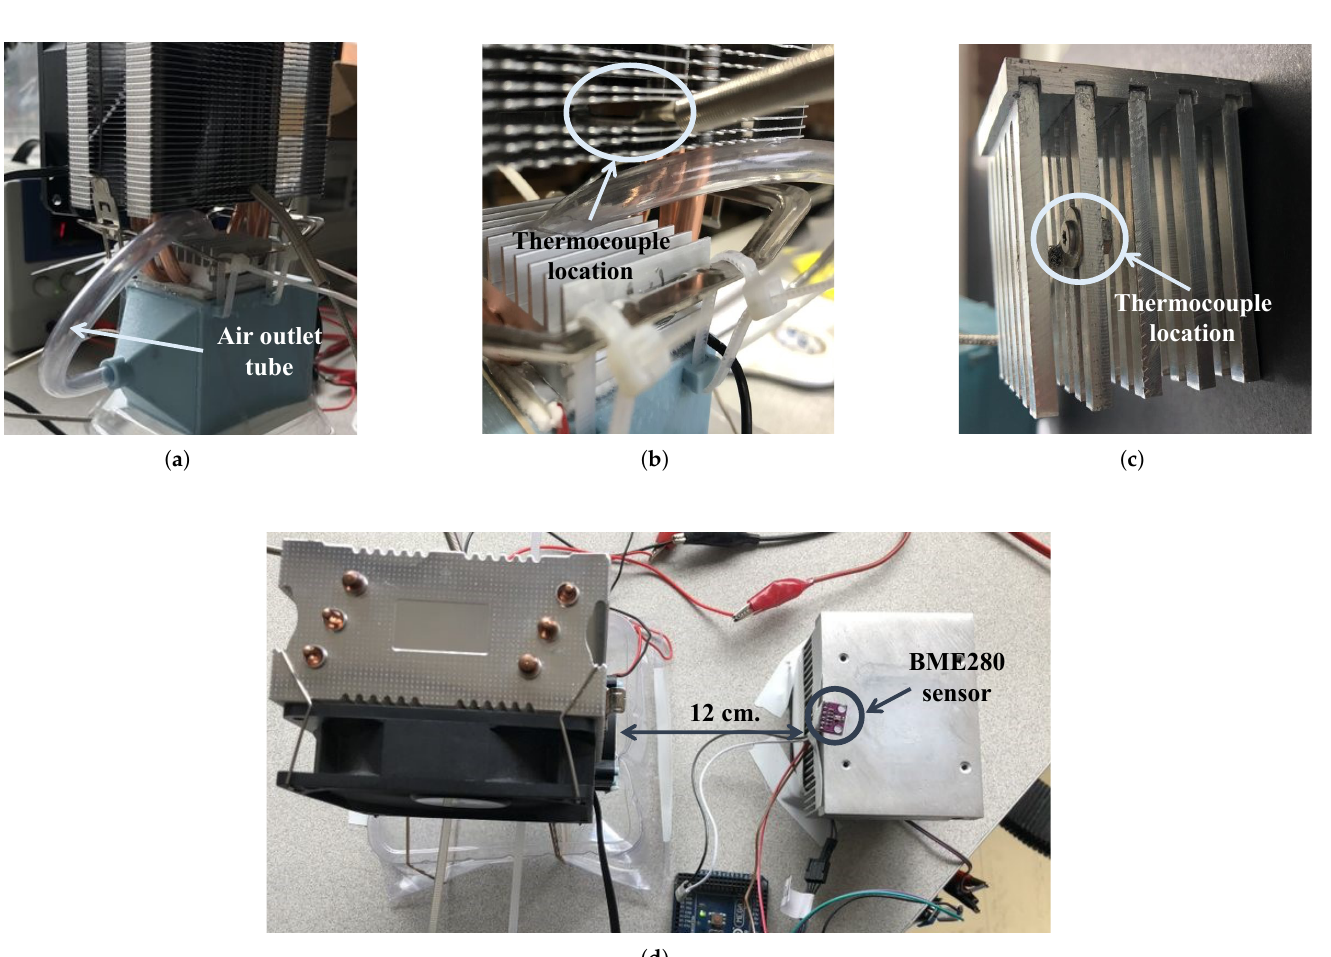
Figure 9. Test conditions ( a ) air outlet tube used; ( b ) thermocouple heat sink location; ( c ) thermocouple location of the water condenser element; ( d ) BME280 sensor location.